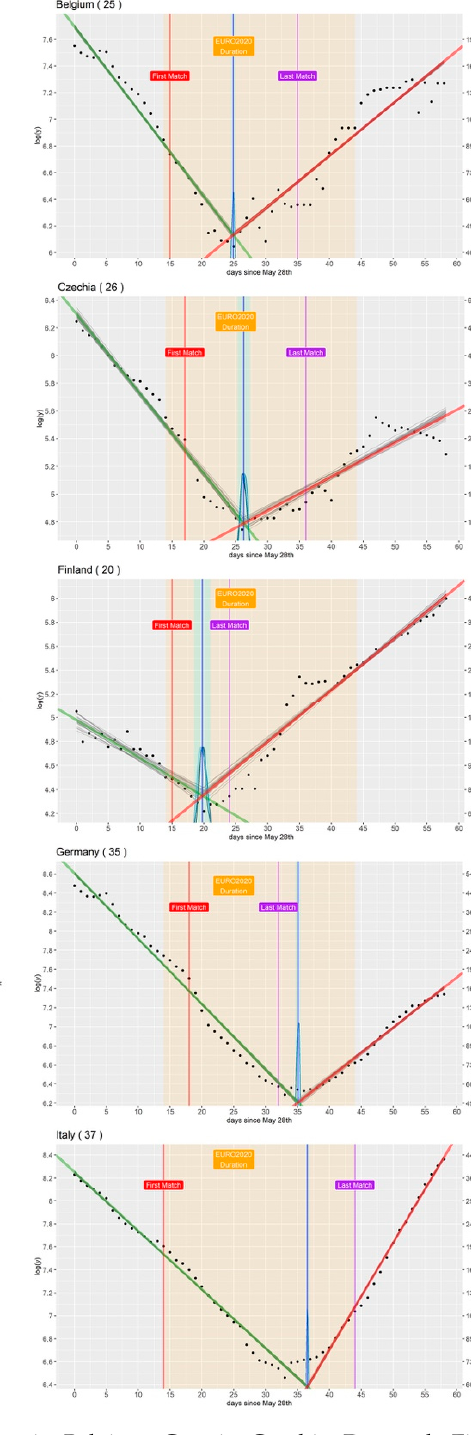
Figure 1. Inversion of the SARS-COV-2 case trend for Austria, Belgium, Croatia, Czechia, Denmark, Finland. France, Germany, Hungary, and Italy, occurring not later than 2–3 weeks after their first match. Yellow space: duration of the tournament. Red vertical line: first match. Purple vertical line: last match. Green vertical line: last hosted match. Blue vertical line: changepoint. Blue space: CI amplitude for the changepoint. Blue bell-shaped peaks: peaks of the probability density function for the changepoint. Green segment: case rate trend before the changepoint. Red segment: case rate trend after the changepoint. Grey segments: fitted lines drawn randomly from the posterior distribution, based on the corresponding CI. Black dots: number of daily CARS-COV-2 cases. Rightmost y axis: number of cases. Leftmost y axis: logarithm of the number of